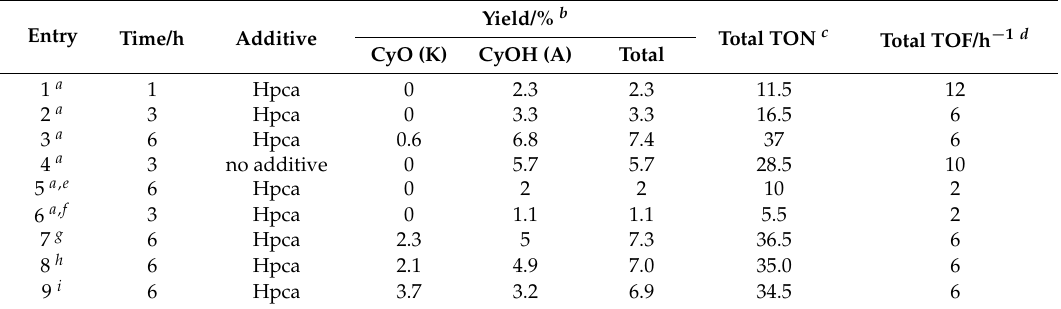
Table 3. Selected data a for the cyclohexane oxidation with TBHP using [FeCl 2 {HC(pz) 3 }] + Fe 3 O 4 ( 2 ) as catalyst, under an external magnetic field.